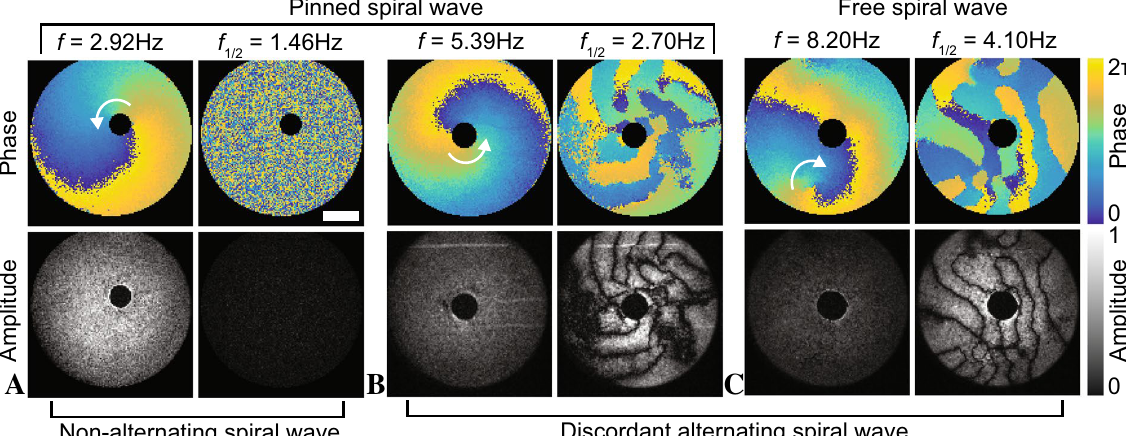
Figure 4. Experimentally observed discordantly alternating spiral waves in confluent cardiomyocyte tissue. The upper and lower images show the phase and amplitude of the spiral waves at the rotating frequency f (left) and the half-frequency f 1/2 (right) in each panel, respectively. ( A ) shows a non-alternating (period-1) obstacle- anchored spiral wave, ( B ) shows an obstacle-anchored spiral wave, and ( C ) shows a free discordantly alternating (period-2) spiral wave. The amplitude is normalized for each spiral wave independently. The discordant alternating spirals show an increase in energy (amplitude) at f 1/2 compared to the rotating frequency f of the spiral. Nodal lines (black regions) are detected at f 1/2 as low-amplitude stripes that separate the high amplitude patches showing the spatially alternating wave